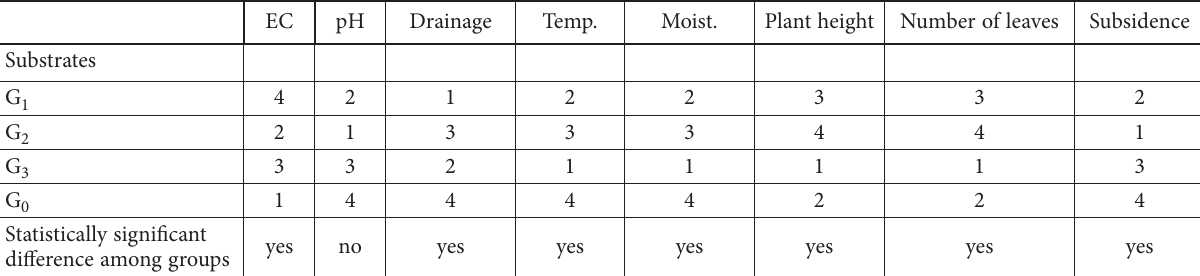
Table 9. Ordinal distribution of factors compared by substrates (1: best; 4: worst) EC pH Drainage Temp.